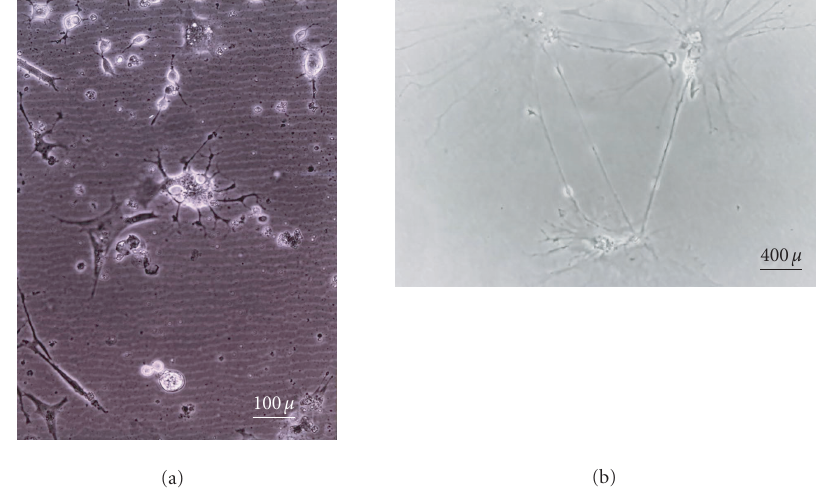
Figure 2. Di ff erentiation of ES cells to osteogenic cells.